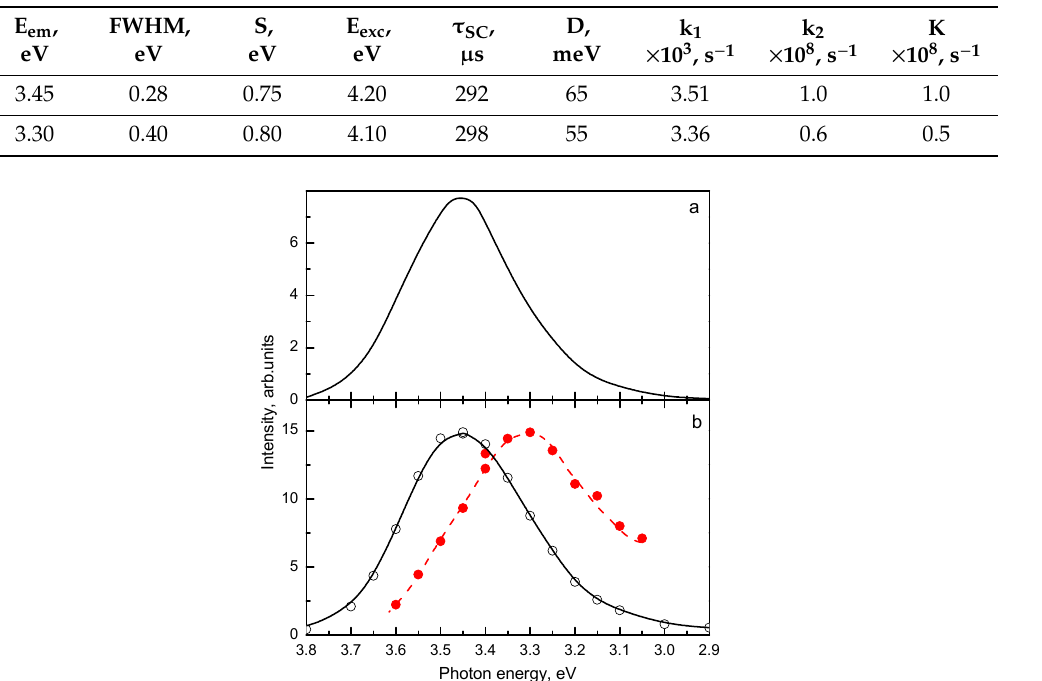
Figure 13. ( a ) The steady-state UV emission spectrum of Lu 2 SiO 5 :Bi measured in [21] under E exc = 4.15 eV and ( b ) time-resolved (t = 300 μ s) emission spectra measured under E exc = 4.15 eV (empty circles) and E exc = 3.8 eV (solid circles). T = 4.2 K. Based on the data reported in [21], presented with the publisher permission.